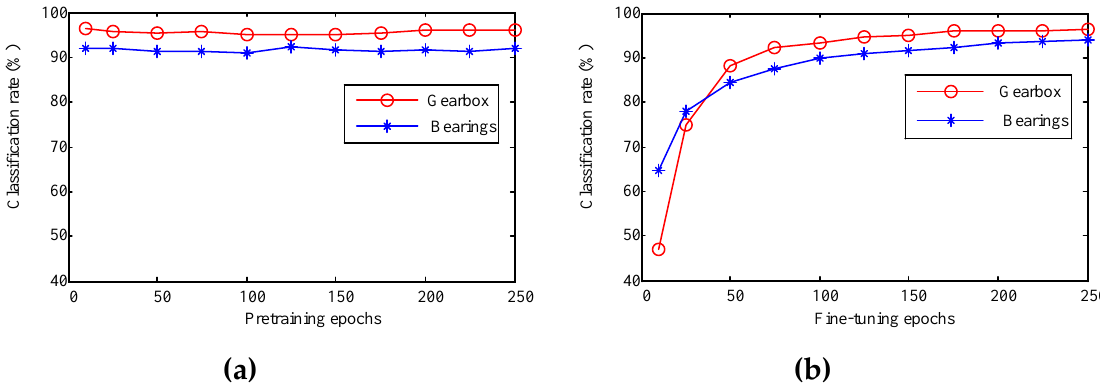
Figure 10. Relationship between the classification rate and the number of the modeling epochs: ( a ) classification rates v.s. pretraining epochs; and ( b ) classification rates vs. fine-tuning epochs of the time-frequency domain GDBM models.